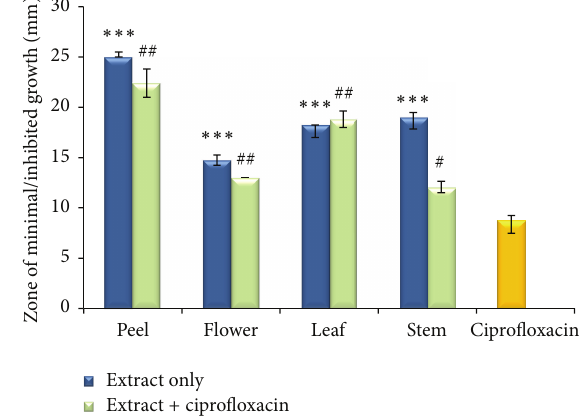
Figure 5: Zone of inhibition or minimum growth (mm) by various parts of Punica granatum on Streptococcus mitis . Values are expressed as mean where error bars represent standard deviation. Significancecomparedtociprofloxacin(positivecontrol): 𝑃 < 0.05 # , 𝑃 < 0.01 ## , 𝑃 < 0.001 ∗∗∗